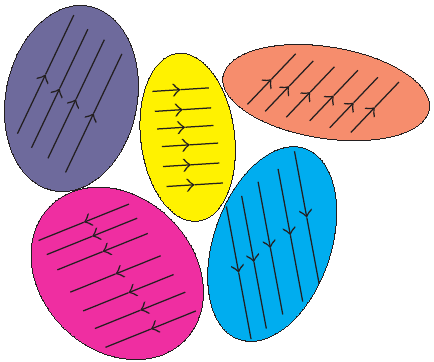
Figure 6: Color fields of the target are locally organized in domains of characteristic size of the inverse saturation scale 1/𝑄 𝑠 , taken from